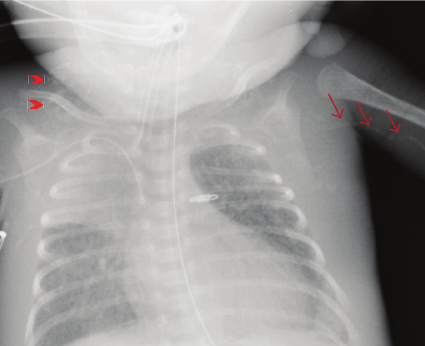
Figure 1: Chest X-ray shows chest soft tissue calcification (arrow heads) and calcification along the left upper arm blood vessels